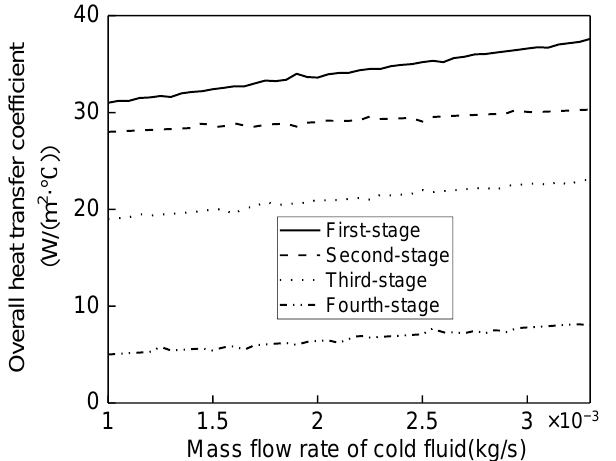
Figure 6. Comparison of the overall heat transfer coefficients of each stage of the four-stage con- densers.